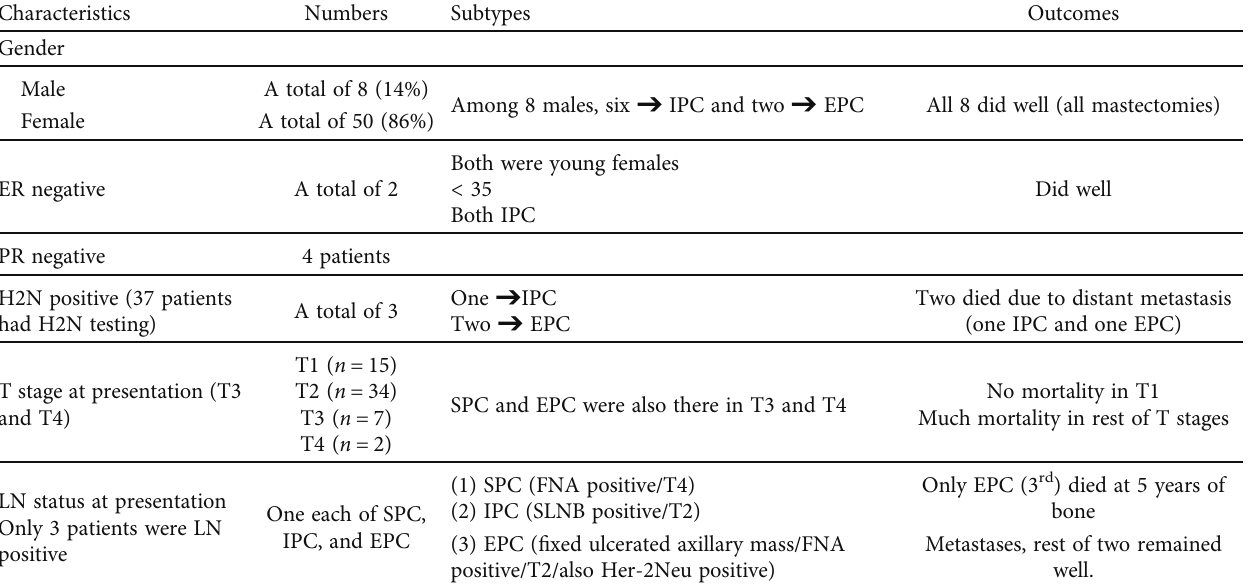
Table 2: Distinctive/unusual features